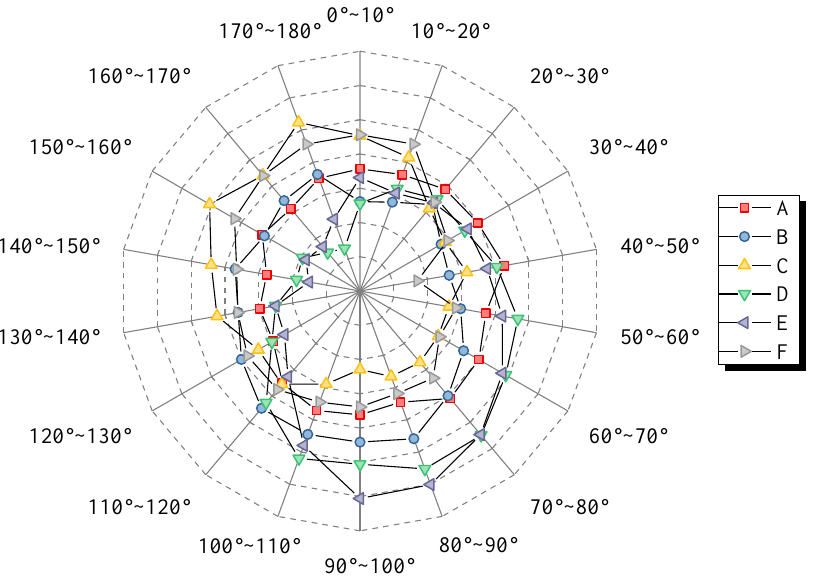
Figure 10. A wind rose diagram of the directional frequency of pores under different consolidation times.